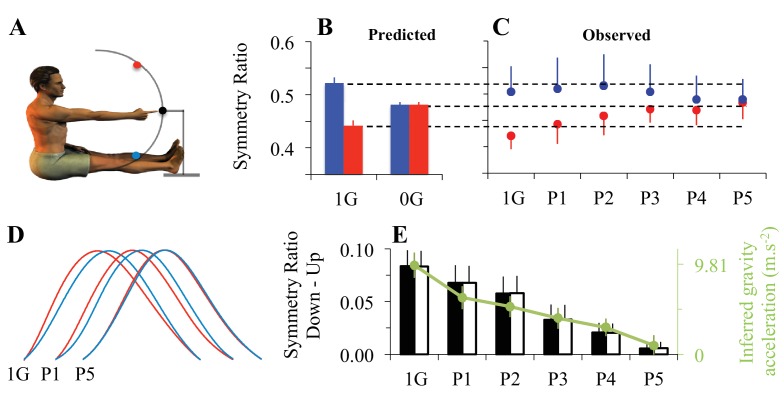
Adaptation to microgravity.(A) Participants’ initial position and positioning of the 3 targets in the sagittal plane. Eleven participants performed fast and visually guided mono-articular arm movements (shoulder rotations) in the sagittal plane under normal gravity (one-G) and micro-gravity conditions (zero-G) during a parabolic flight (parabola 1, P1 to parabola 5, P5). (B) Symmetry ratios (acceleration time / movement time) predicted by the Minimum Smooth-Effort model in one-G and in zero-G conditions. (C) Symmetry ratios experimentally recorded before (1g) and during adaptation to zero-G (P1 to P5). (D) Mean velocity profiles, normalized in amplitude and duration. Qualitative comparisons between upward and downward arm movements illustrate the progressive decrease of directional asymmetries when subjects adapted to the new microgravity environment. (E) Vertical bars represent the average symmetry ratio (black vertical axis, left) for the recorded (black filled bars) and simulated (black open bars) data in one-G and during zero-G (P1 to P5) environments. For simulated data, the g value was fitted (−2*G<g<2*G) in order to best predict the measured symmetry ratios. These fitted g values, represented by the green dots (green vertical axis, right), reveal a progressive decrease of the g internal model value during zero-G exposure. Error bars illustrate SD and color-coded arrows denote movement direction (red = up; blue = down). See also Figure 3—figure supplement 1.